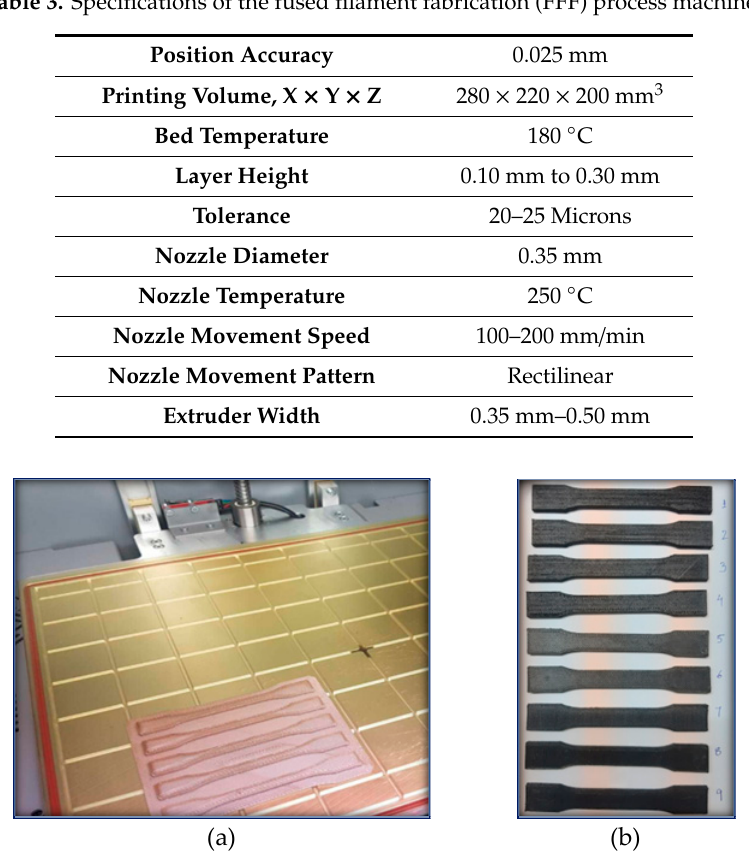
Figure 4. ( a ) Standard test specimen on ARGO machine bed: (b) 3D printed CPEEK specimens. Table 3. Specifications of the fused filament fabrication (FFF) process machine.